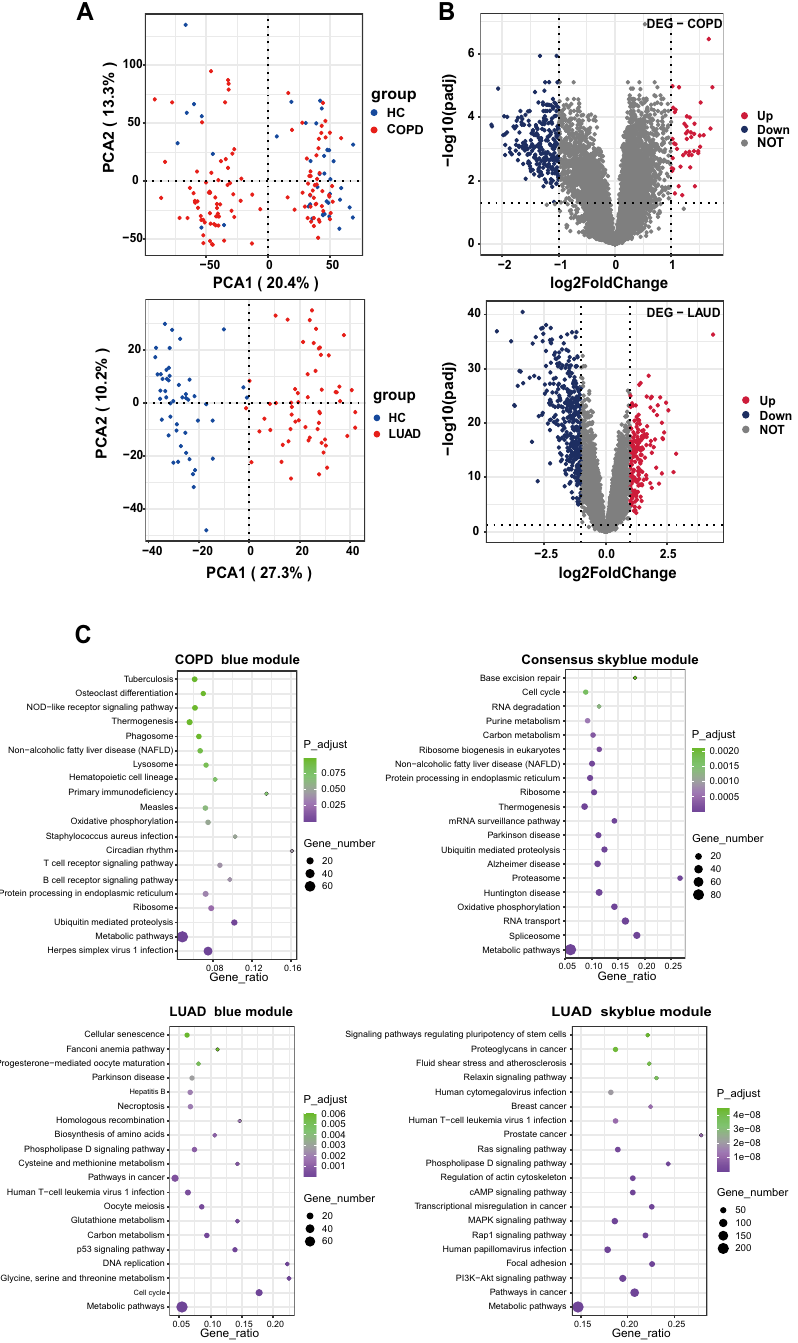
Figure 2. ( A ), the PCA plots showed a clear separation in two datasets. Blue spots represent the control group, and red spots represent the healthy people group. ( B ), volcano graph shows the differential gene expression, upregulated (blue box), downregulated (red box), and unchanged (gray boxes) transcripts. ( C ), KEGG pathway analysis for the target genes of the Important modules. COPD: chronic obstructive pulmonary disease; LUAD: lung adenocarcinoma; KEGG: Kyoto Encyclopedia of Genes and